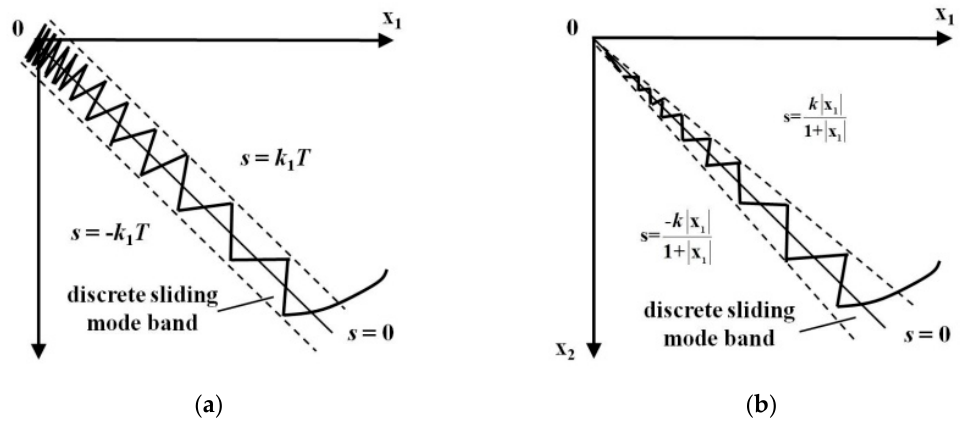
Figure 2. Sliding mode band of ( a ) conventional reaching law and ( b ) novel reaching law [11]. Reproduced with permission from Xiaoguang et al., Nonlinear speed control for PMSM system using sliding mode control and disturbance compensation techniques; published by IEEE Transactions on Power Electronics, 2013.